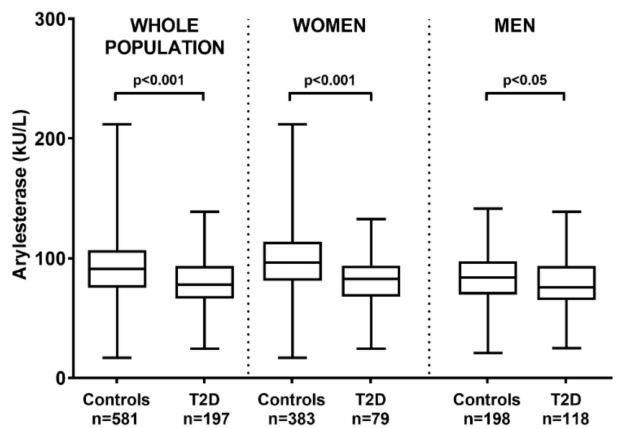
Figure 1. PON-arylesterase activity measured in the whole population, or subjects grouped in women and men. As depicted, we found significantly lower levels of PON-arylesterase activity in subjects a ff ected by T2D compared with controls ( p < 0.001), the di ff erence was maintained also within sexes ( p < 0.001 and p < 0.05, for women and men, respectively). Mann–Whitney U test was used for comparisons. PON: paraoxonase-1; T2D: Type 2